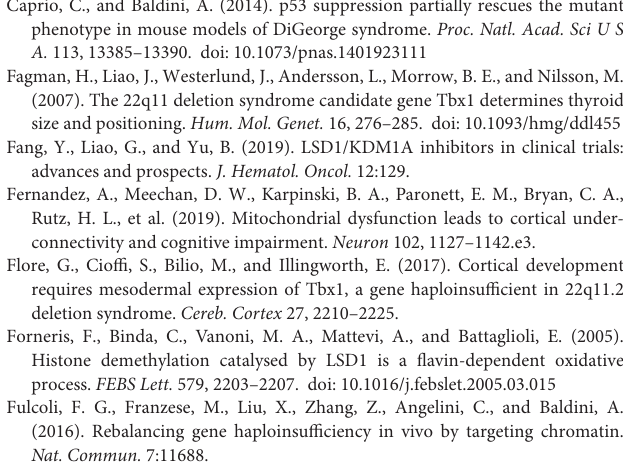
Supplementary Figure 1 | Thickness of ML-cortex is not altered in Tbx1 mutant embryos at E13.5. The cartoon (A) indicates the position of the ML-cortex in coronal brain sections (boxed area) at E13.5. The red line indicates the position where cortical thickness (ventricular-to-pial surface) was measured. Cortical thickness was similar in all genotypes and treatment groups that included B12-treated and vehicle-treated Tbx1 lacZ / + embryos (B) or Tbx1 lacZ / LacZ embryos (C)